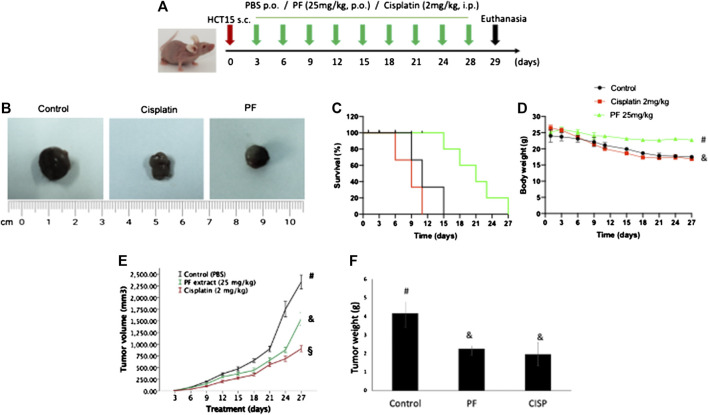
Antitumor effect of the polyphenolic fraction from T. testudinum extract in nu/nu mice. Animals (n = 5) were orally treated for 27 days with the polyphenolic fraction (25 mg/kg), or intraperitoneally with cisplatin (4 mg/kg) after xenograft model of HCT15 was established (A). Control group: animals treated with oral doses of PBS. Representative tumoral mass after mice’s euthanasia (B). Mean ± standard deviation of tumor volume and weight (E,F). Survival rate and body weight (G) behavior during the experiment (C,D).